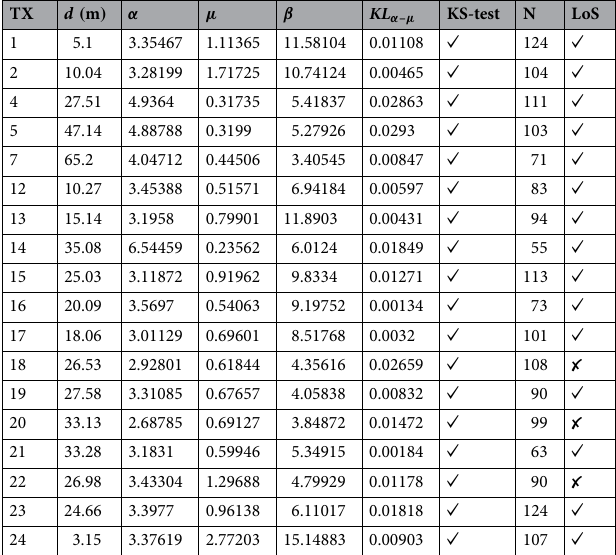
Table 1. Shopping mall links parameters of the α – µ distribution.